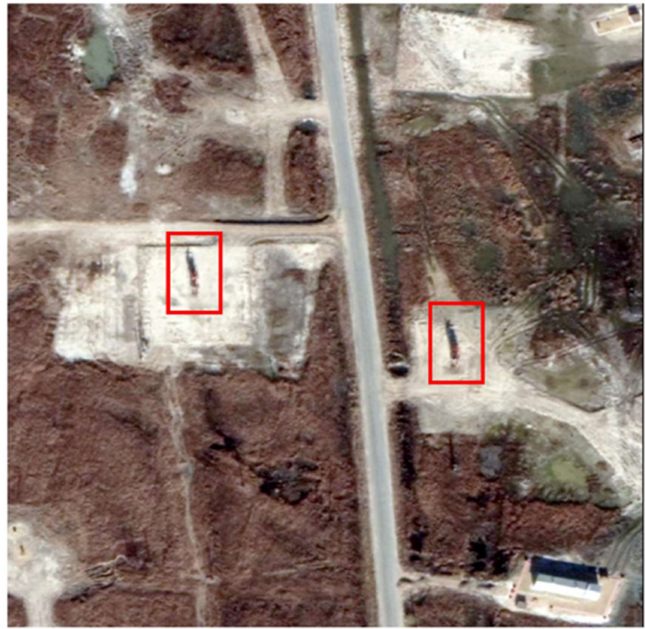
Figure 16. Oil wells constructed in the north–south